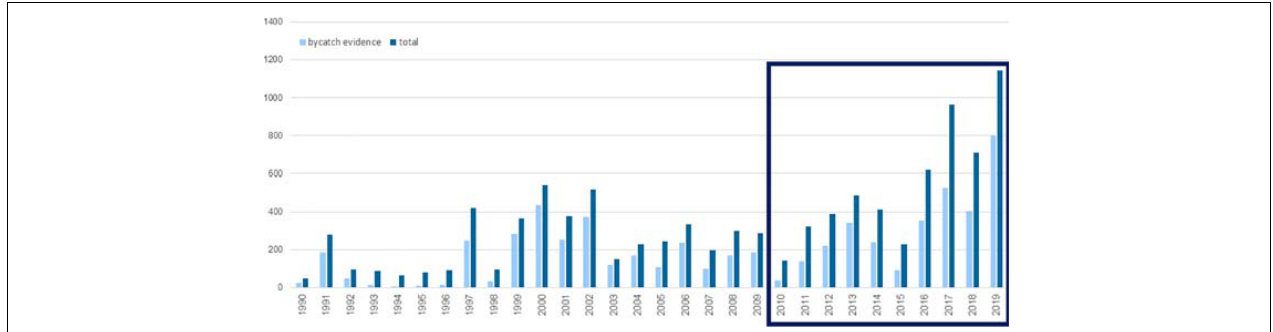
FIGURE 4 | Long term time series of common dolphin strandings along the French Atlantic coast, from 1990 to 2009. Dark blue bars represent all common dolphin strandings, light blue bars represent examined common dolphin strandings (fresh or slightly decomposed) with bycatch evidence. The dark blue box incorporates the years included in the study to identify positive correlations between mortality areas and fishing effort.